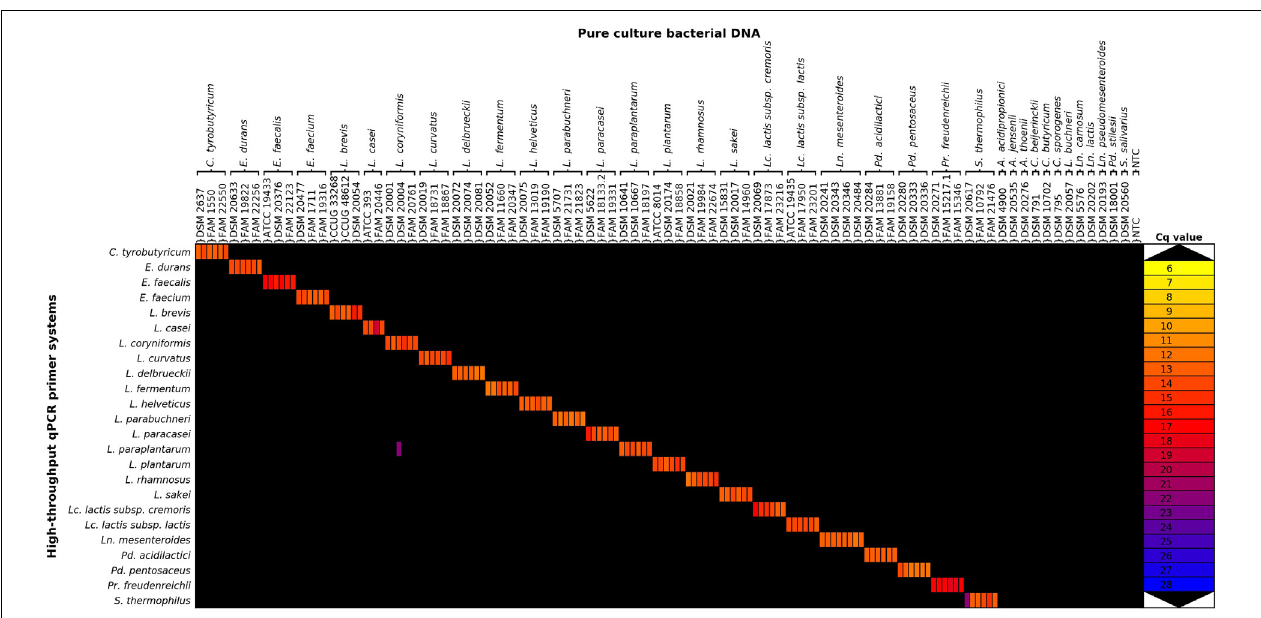
FIGURE 2 | Heatmap of filtered average quantification cycle data of the exclusivity assessment. Average Cq values of the filtered Cq data are represented, but only data points where at least two of the three technical replicates were positive are depicted. Raw Cq data and filtered Cq data heatmaps are available in Supplementary Figures S3, S4 in Supplementary Data Sheet 3 . A ., Acidipropionibacterium ; C ., Clostridium ; E ., Enterococcus ; L ., Lactobacillus ; Lc ., Lactococcus ; Ln ., Leuconostoc ; Pd ., Pediococcus ; Pr. , Propionibacterium ; S ., Streptococcus ; NTC, no template